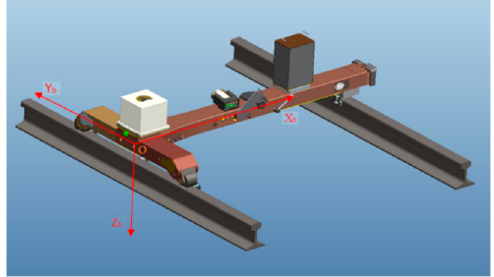
Figure 1. The carrier coordinate system (b system).